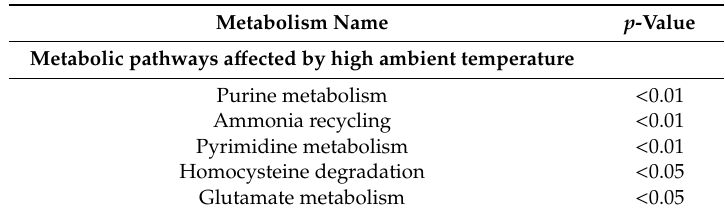
Table 5. E ff ects of a cyclic high ambient temperature and feeding orotic acid on metabolisms of broiler